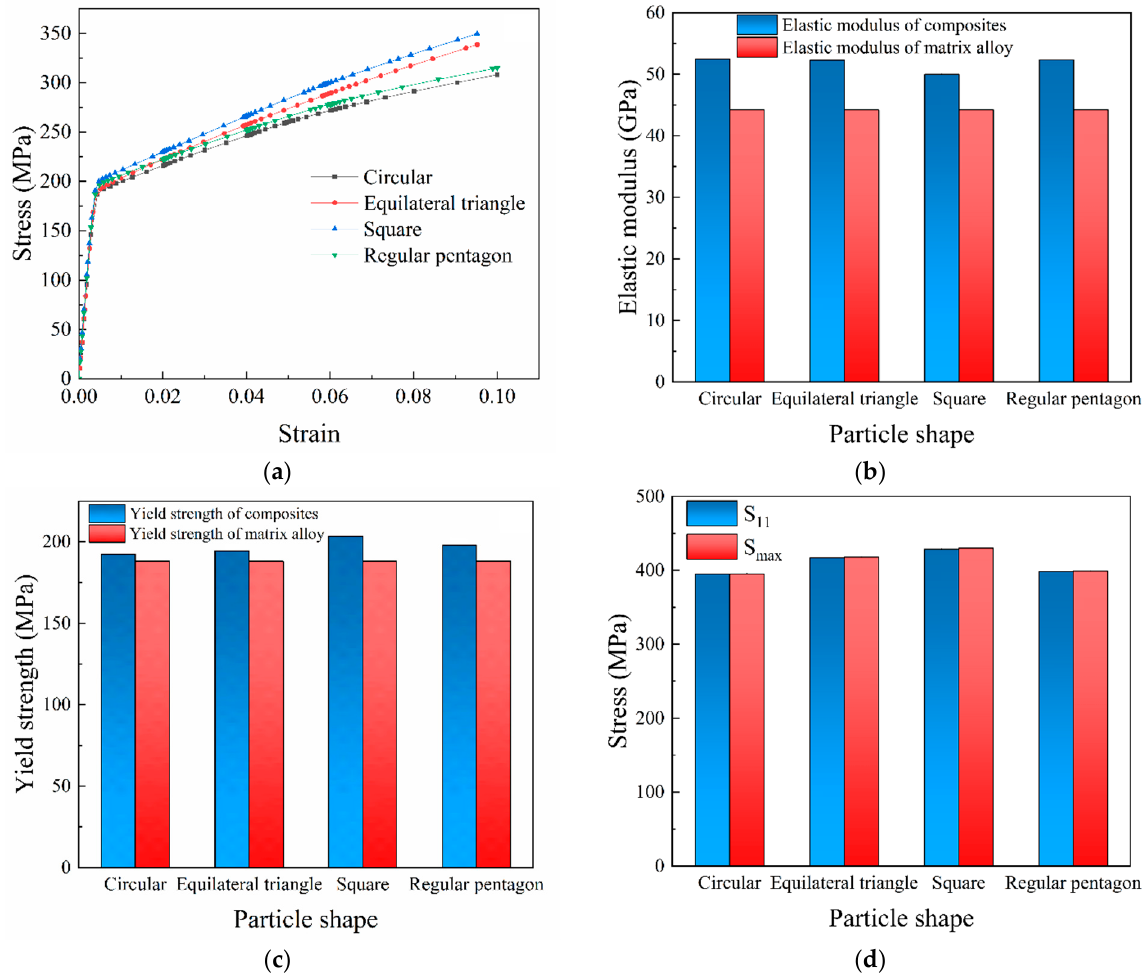
Figure 4. ( a ) Stress–strain curves, ( b ) comparison of elastic modulus, ( c ) comparison of nominal yield strength, ( d ) comparison of S 11 and S max . strength, ( d ) comparison of S 11 and S max